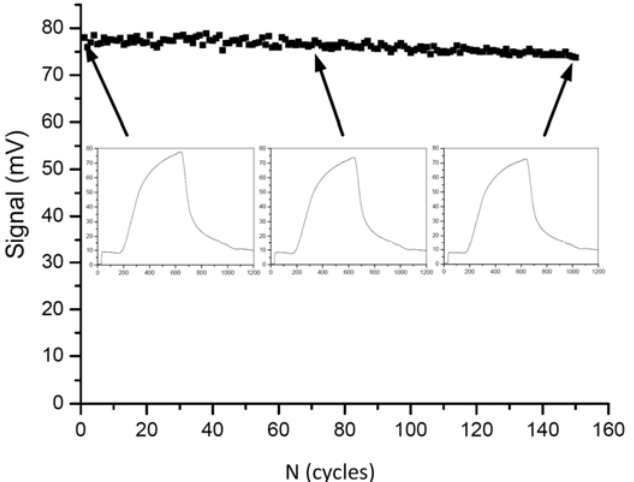
Figure 1. One hundred and fifty repetitive sensor cycles in absence of microcystin. Reprinted with permission from [132] Copyright 2009